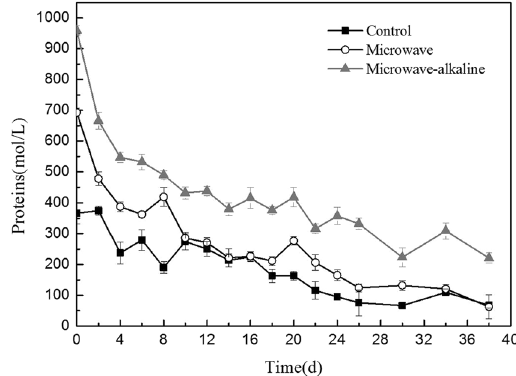
Figure 3. Changes of soluble organics during the anaerobic digestion after different pretreatments.